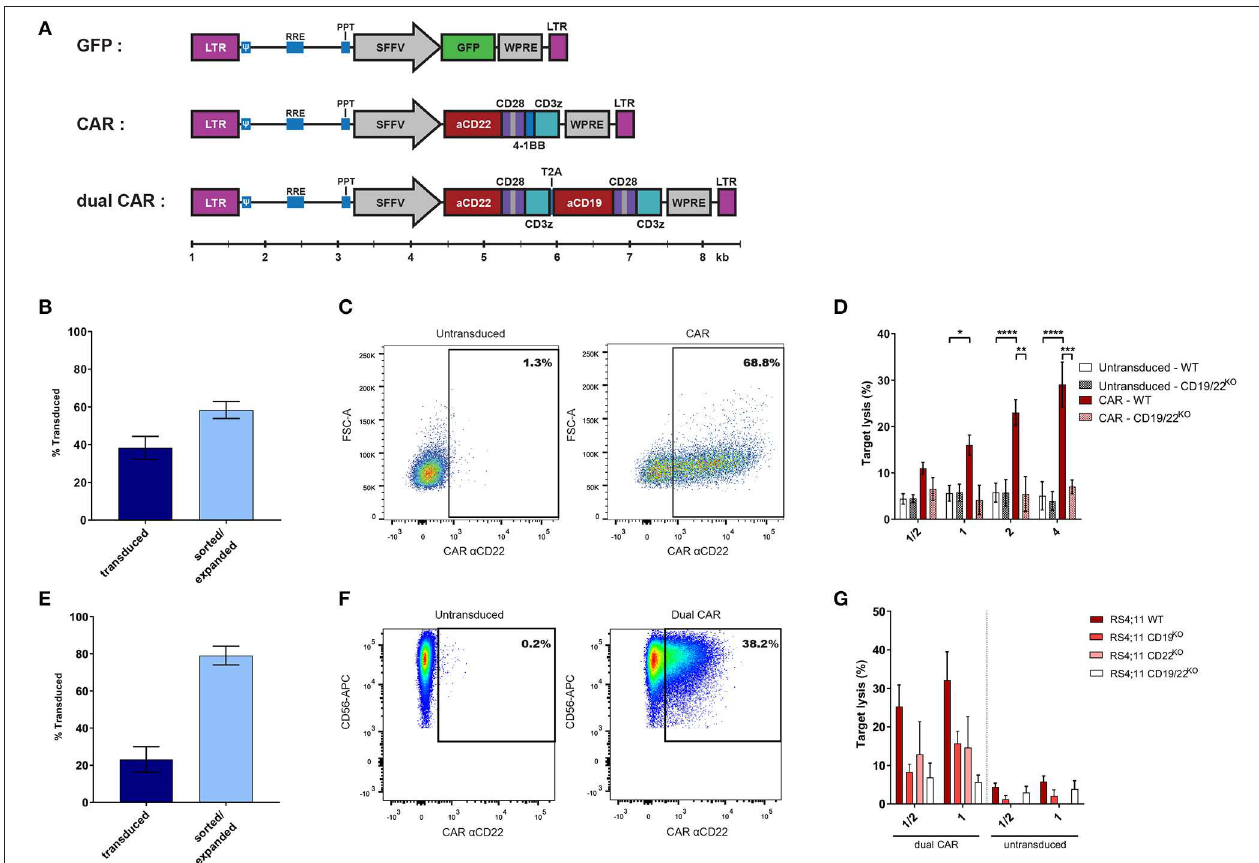
FIGURE 3 | BaEV-LVs allow robust CAR-expression in NK-cells. (A) Schematic representation of the different LVs used for NK-cell transduction using BaEV-LV (relative scale according to size in base pairs). (B) Percentage of transduced NKAES cells using BaEV-LVs coding for an anti-CD22 CAR, assessed at day 3 after transduction (“transduced”; n = 15) and after sorting and 1 week of re-expansion (“sorted/expanded”; n = 3). (C) Flow cytometry plot representative of CAR-CD22 expression after NK-cell transduction with BaEV-LVs. (D) Cytotoxic assays of NKAES (either untransduced or CAR-CD22-NK-cells) against either parental (WT; n = 7) or CD19/22 KO -RS4;11 cells (B-ALL; n = 2) (* p < 0.05, ** p < 0.01, *** p < 0.001, **** p < 0.0001; 2-way ANOVA test with multiple testing and Bonferroni correction). (E) Percentage of transduced NKAES cells using BaEV-LVs coding for the dual CAR assessed at day 3 after transduction (“transduced”; n = 9) and after sorting and 2 weeks of re-expansion (“sorted/expanded”; n = 3). (F) Flow cytometry plot representative of dual CAR expression after NK-cell transduction with BaEV-LVs. (G) Cytotoxic assays using NKAES cells transduced with a dual CAR (left panel) or untransduced NKAES (right panel) against either parental (WT; n = 8 each), CD19 KO ( n = 3 for untransduced, n = 4 for CAR transduced), CD22 KO ( n = 1 for untransduced, n = 2 for CAR transduced) or CD19/CD22 KO RS4;11 B-ALL cells ( n = 3 for untransduced, n = 5 for CAR transduced). Data are presented as the mean ± SEM.